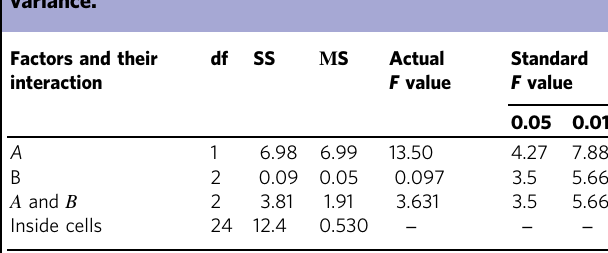
Table 4 The effect of the original method for improving physical fi tness on the control and experimental groups in different weight categories of boxers, a two-way analysis of